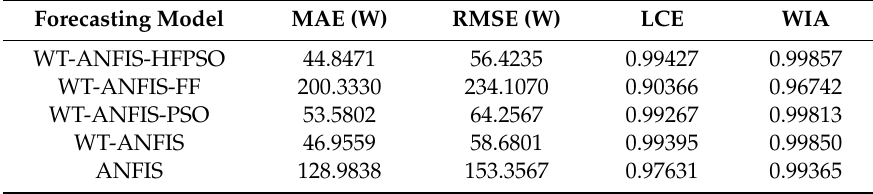
Table 4. Performance comparison of forecasting models on sunny